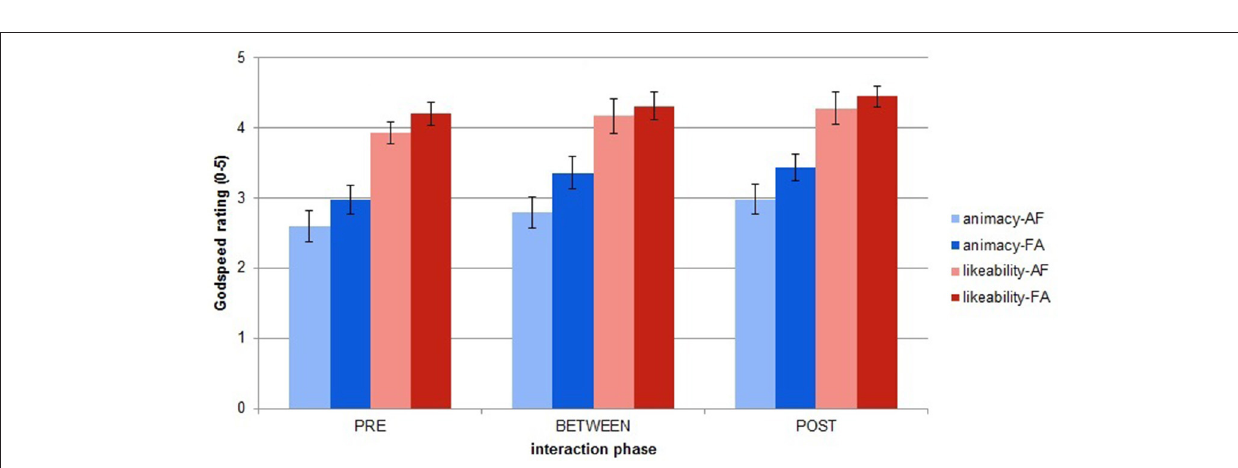
FIGURE 9 | Godspeed ratings averages across order and phases. Error bars represent standard